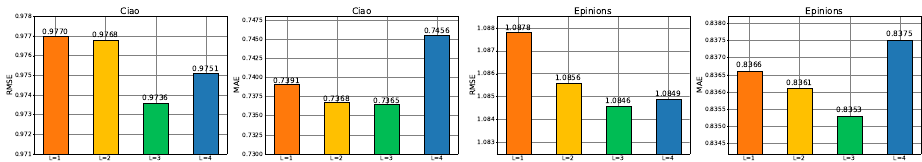
Figure 2. The impact of the number of embedding propagation layers L .